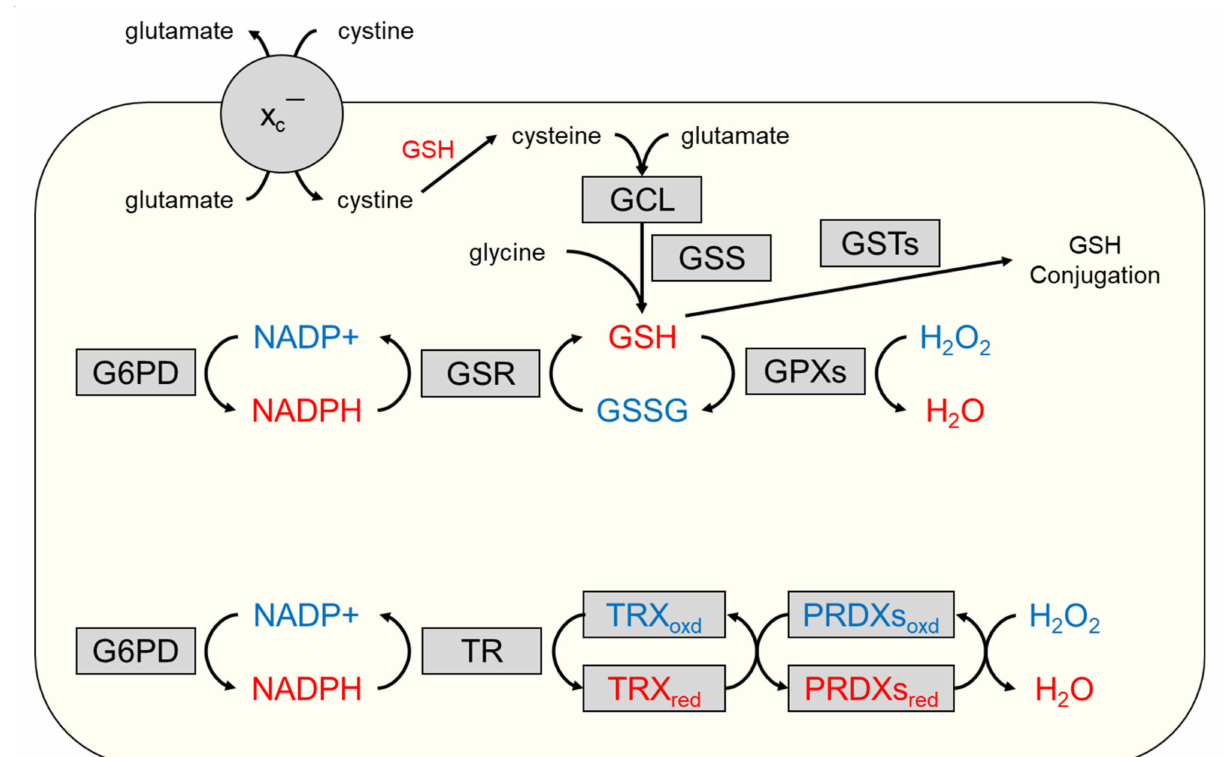
Figure 3. Schematic overview of the cysteine-dependent glutathione (top) and thioredoxin (bottom) antioxidant systems. The glutathione antioxidant system is comprised of the enzymes necessary for the synthesis, utilization, and recycling of the tripeptide glutathione. The amino acid cysteine is essential to both the glutathione and thioredoxin antioxidant systems and is taken into the cell in the form of the disulfide dimer cystine by the cystine/glutamate antiporter xCT (system x c − ), the protein subunits of which are encoded by NRF2 transcriptional targets SLC7A11 and SLC3A2 . Cystine is rapidly reduced into cysteine in cytosol to be further utilized by the cell. The thioredoxin antioxidant system is comprised of the enzymes necessary for the utilization and recycling of the thioredoxin enzyme. Proteins in grey shapes are encoded by genes directly regulated by NRF2 through AREs. The blue text in the figure indicates the oxidized form of a molecule/protein, and the red text indicates the reduced form. ARE, antioxidant response element; G6PD, glucose-6-phosphate dehydrogenase; GCL, glutamate cysteine ligase; GPX, glutathione peroxidase; GSH, glutathione GSR, glutathione reductase; GSS, glutathione synthetase; GST, glutathione-S-transferase; PRDX, peroxiredoxin; TR, thioredoxin reductase; and TRX,